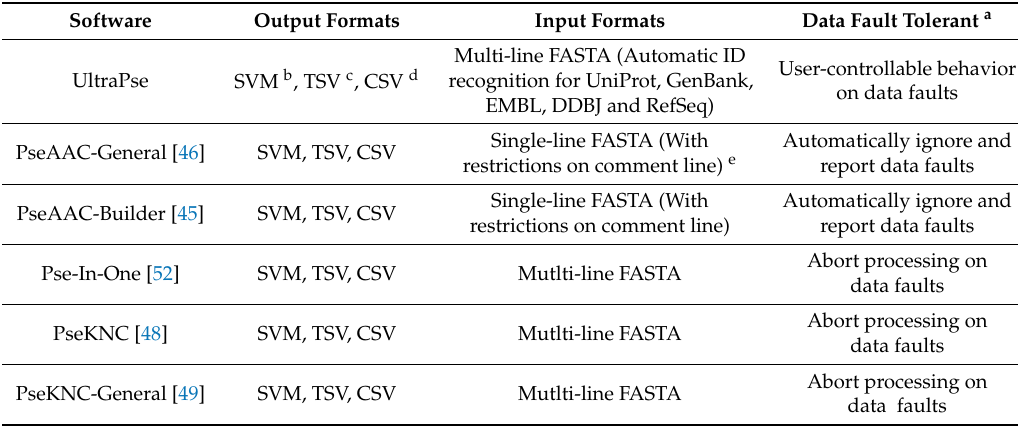
Table 2. Software function comparison in terms of data processing